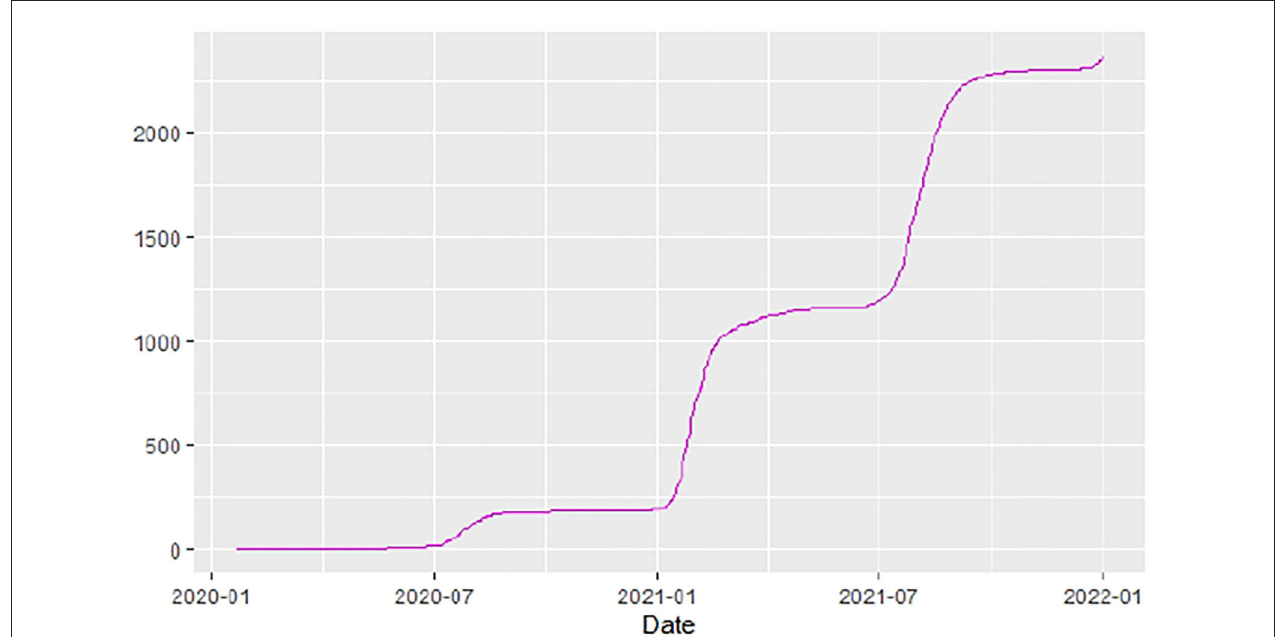
FIGURE 15 | Malawi deaths.